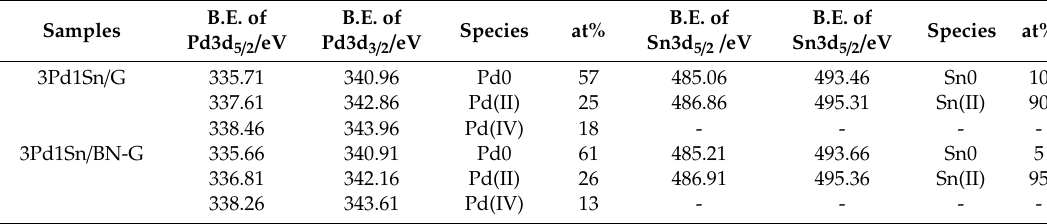
Table 2. Fitting results of 3Pd1Sn / G and 3Pd1Sn / B-N-G from XPS in Figure